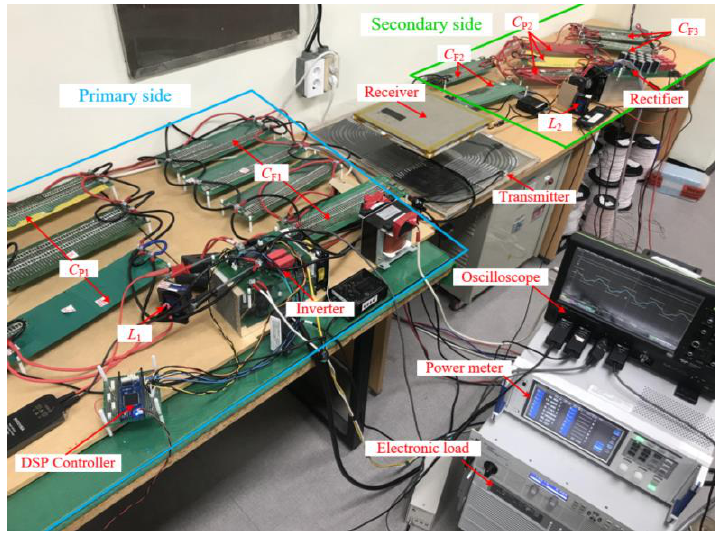
Figure 14. Experimental prototype of the proposed WPT battery charger. Table 1. Designed parameters of the proposed WPT charger. Symbols Symbols Symbols Symbols U IN